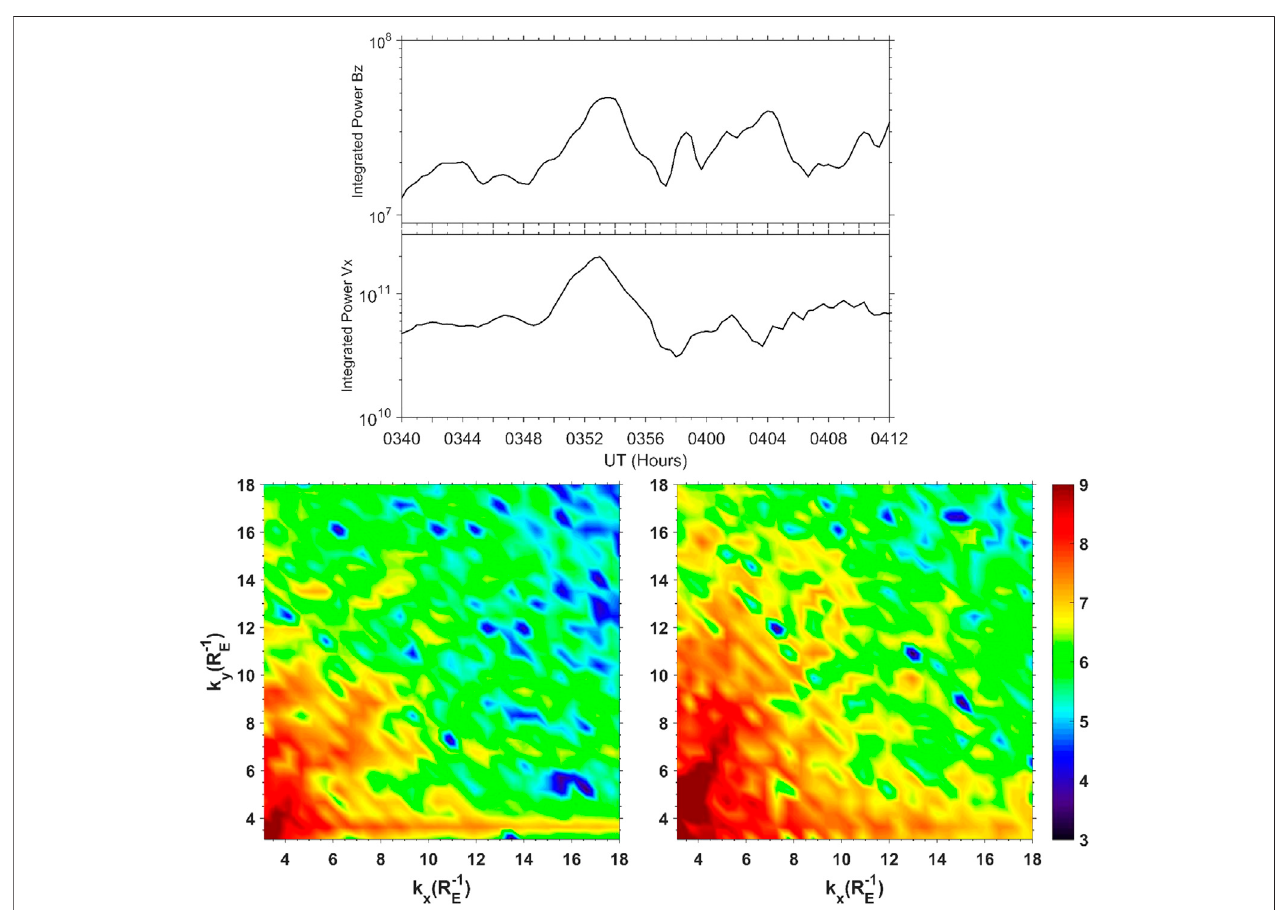
FIGURE11| Timehistoryoftotalsmallandmesoscalespectralpowerinthevicinityof fl owchannelsanddipolarizations.Fortheregionbetween − 10and − 22 R E in x and − 4to8 R E iny,thesumofthepowerinall x and y formodenumbersgreaterthantwowascomputed(toptwopanels).Thetoppanelshowstheresultfor B z ,inunitsof nT 2 , and the panel below it shows the result for V x , in units of (km/s) 2 . The lower two panels show the power, in units of (R E · km/s) 2 , vs. wavenumber at two times, 0344 UT on the left and 0353 UT on the right. (After El-Alaoui et al. (2016)).